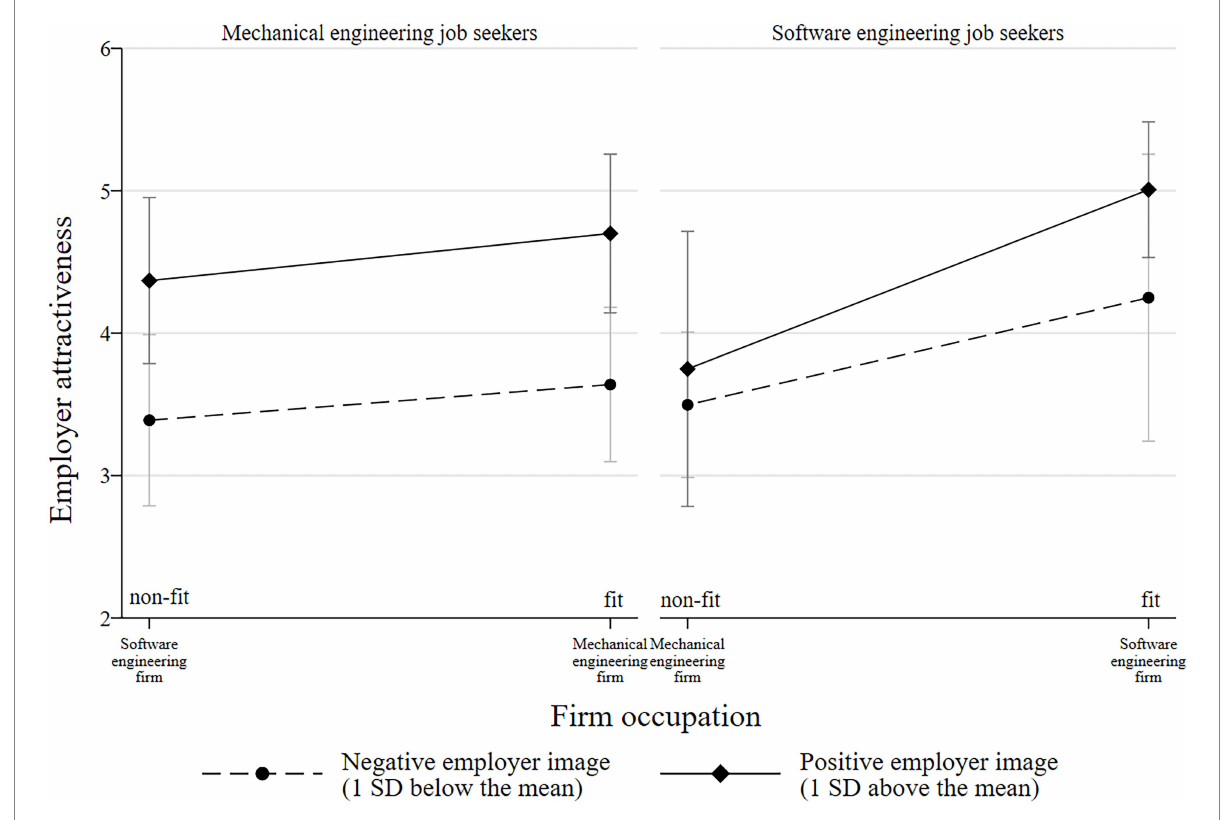
FIGURE 2 Interaction between employer image, firm occupation, and job seeker occupation with 95% confidence intervals (Model